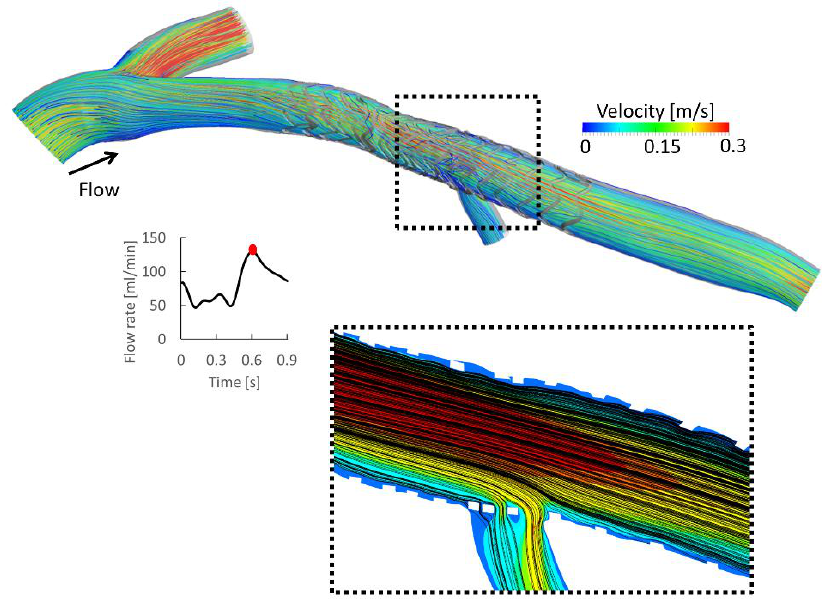
Figure 4. Streamlines of the velocity colored by the velocity magnitude (top) and the in-plane velocity contour map with in-plane streamlines (bottom) at peak flow-rate.